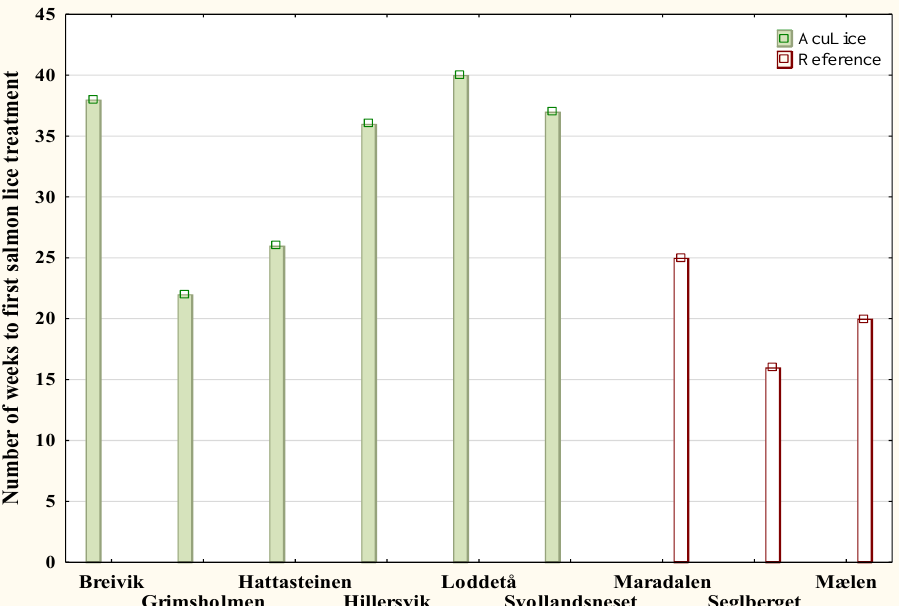
Figure 8. Mean number of weeks to the first salmon lice treatment at the experimental facilities in field trial 2. Green marked columns are facilities with AcuLice treatment and red columns are the reference facilities.